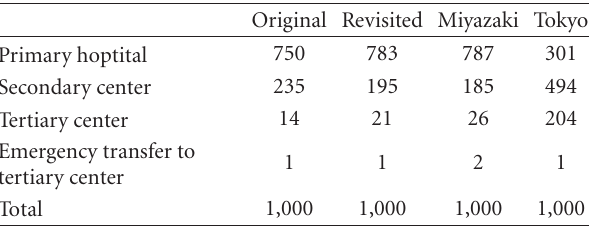
Table 1: Prevalence of risk-allocated persons per 1,000 in each study.